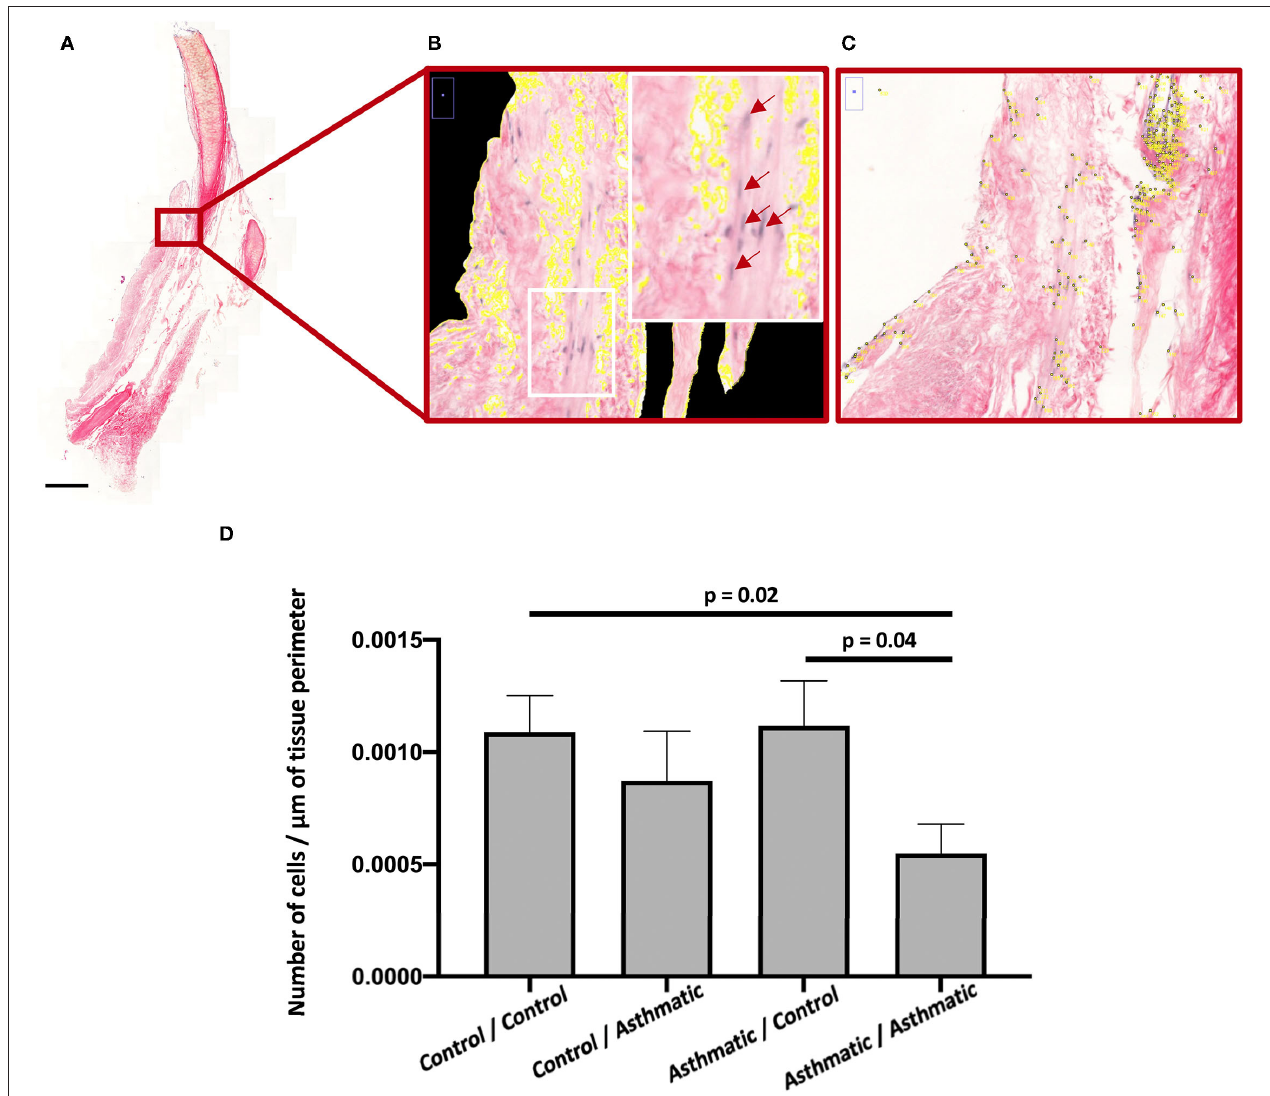
FIGURE 2 | ASM cell proliferation. (A) Hematoxylin-eosin-phloxine-safran (HEPS) staining of recellularized matrices at 200 magnification for histomorphometry. (B) Zoom on perimeter calculation on a scan section at magnification 200, the white rectangle is focused on a section containing ASM cells stained in purple with some positive nuclei identified by red arrows. (C) Point counting zoom on a scan section at magnification 200. (D) Number of nuclei per µ m in the asthmatic matrix/asthmatic cell group was significantly decreased compared with the control matrix/control cell and asthmatic matrix/asthmatic cell